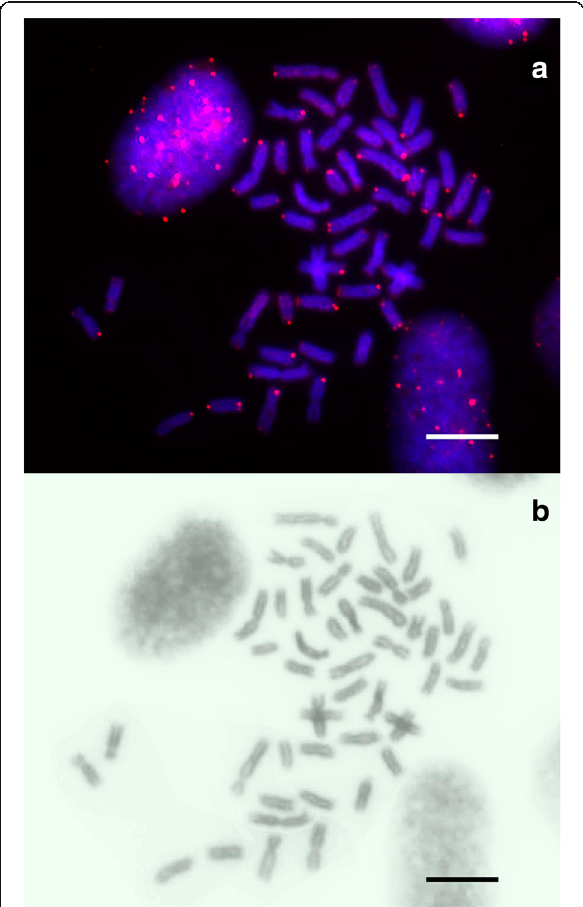
Fig. 3 Mitotic metaphase of Cheirodon pisciculus after sequential FISH with telomeric repeats ( a ) and C-banding ( b ). Bar equal 10 μ